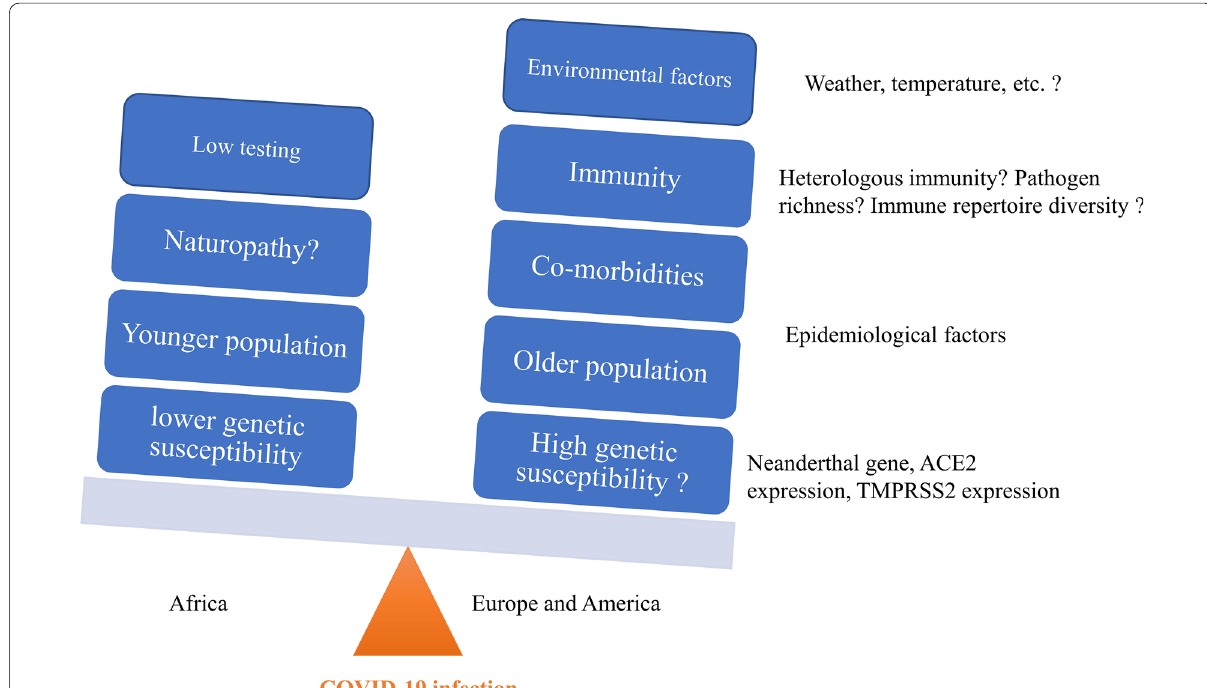
Fig. 1 Summary of the reasons for the low burden of COVID-19 in Africa. The higher burden of COVID-19 in European and American continents and possibly responsible factors are